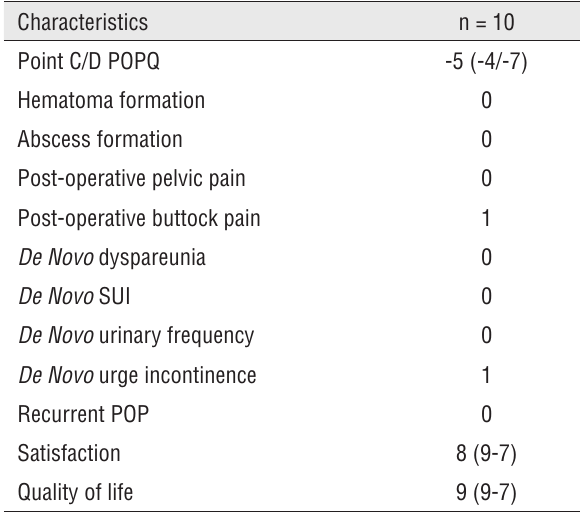
Table 3 – Postoperative outcomes of patients who underwent neuGuide™ surgery.